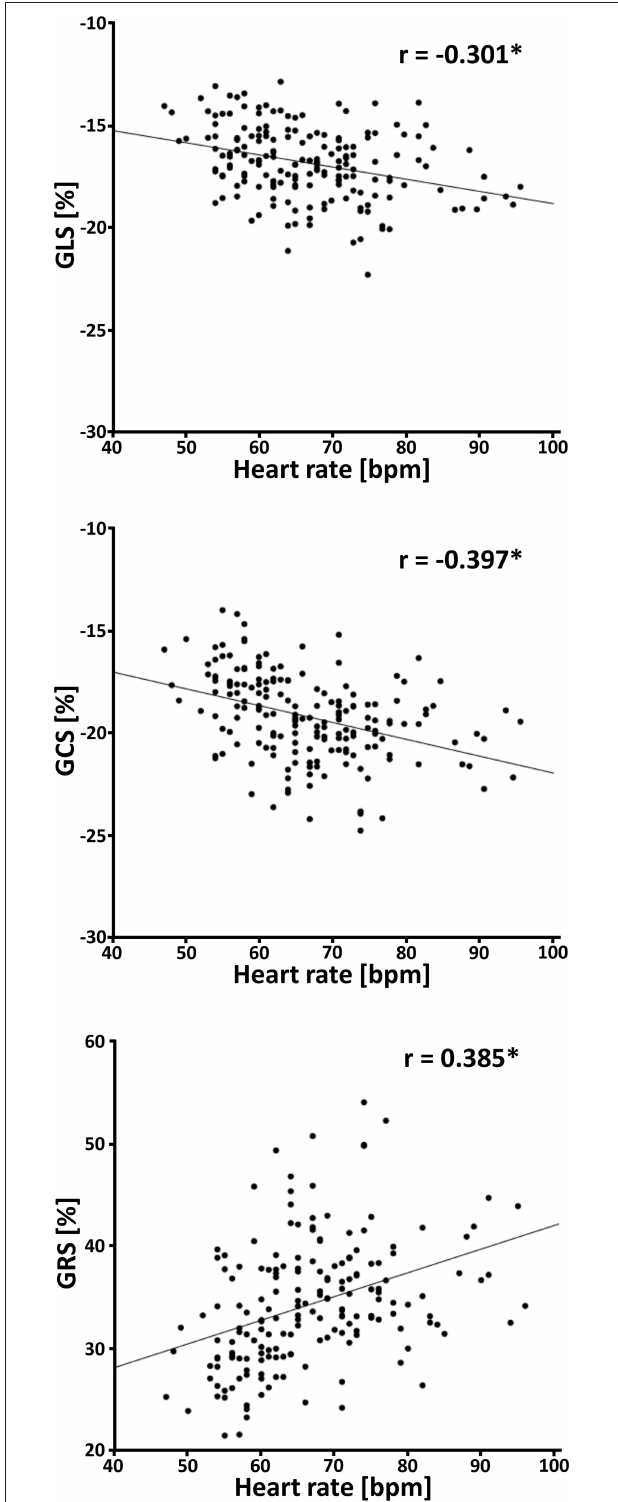
FIGURE 7 | Correlation between heart rate and strain values in healthy subjects. GLS, global longitudinal strain; GCS, global circumferential strain; GRS, global radial strain; bpm, beats per minute; * p ≤